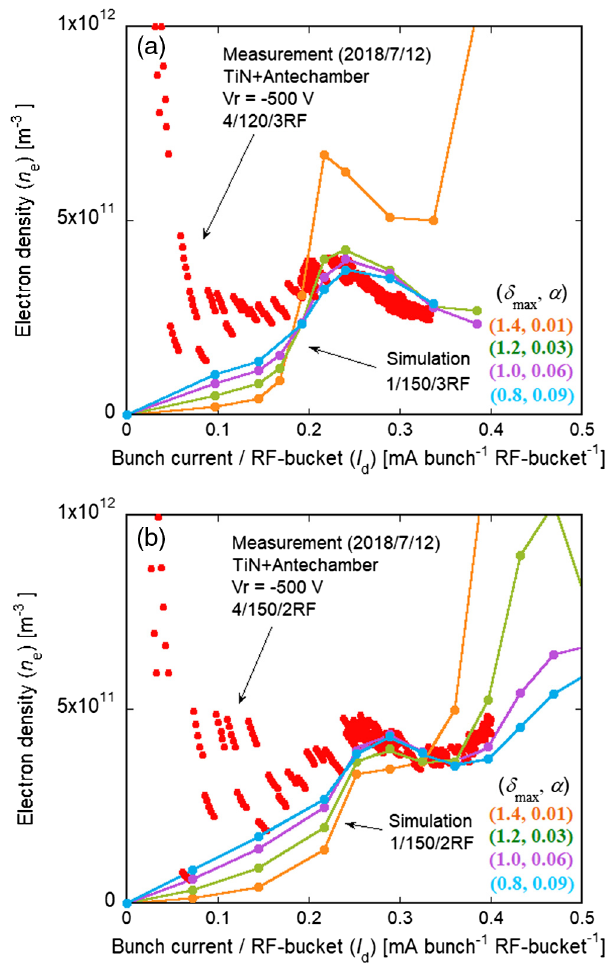
FIG. 18. Measured electron density ( n e ) near the beam orbit and calculated density for several combinations of ( δ function of the current linear density ( I d ) for bunch fill patterns of (a) two and (b) three rf-bucket